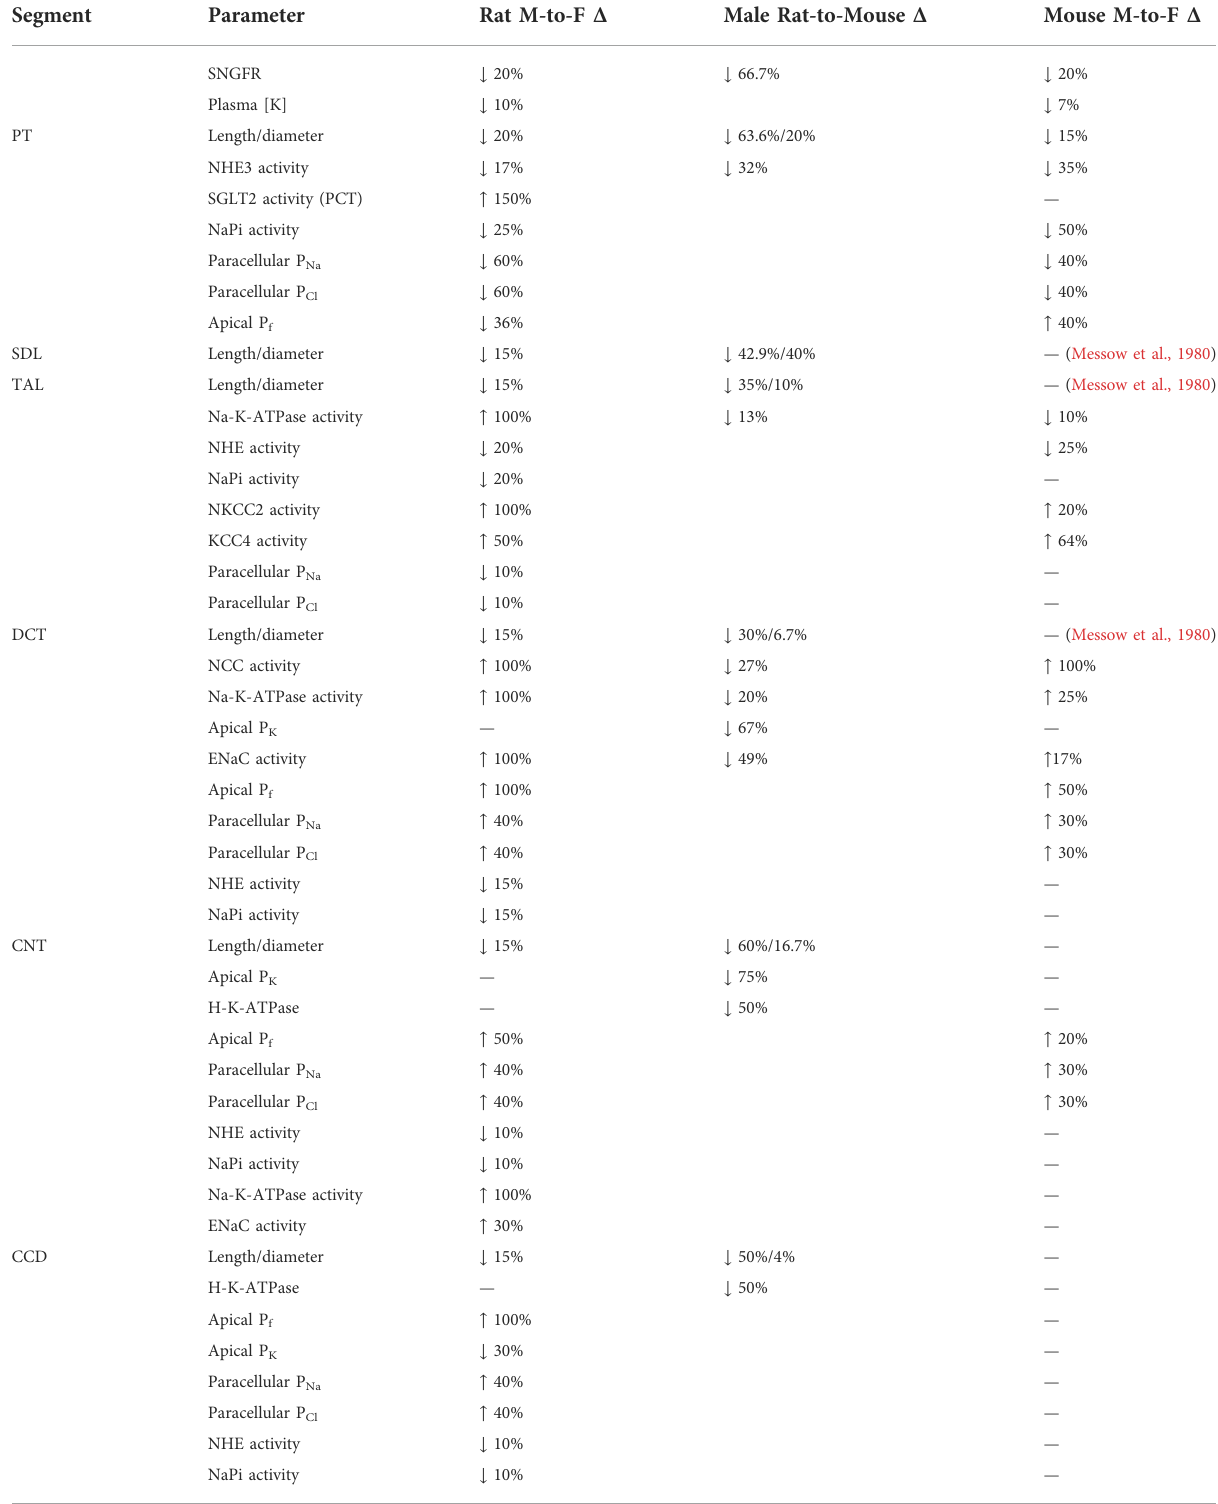
TABLE 1 Key parameter differences between male rat and male mousenephronmodels, between male and female rat nephron models, and between maleandfemalemousenephronmodels.Ratparametersaretakenfrompublishedmodels(Huetal.,2019;Huetal.,2020).Mouseparametersare based on data from Refs. (Messow et al., 1980; Veiras et al., 2017; Tahaei et al., 2020; Xu et al., 2021).